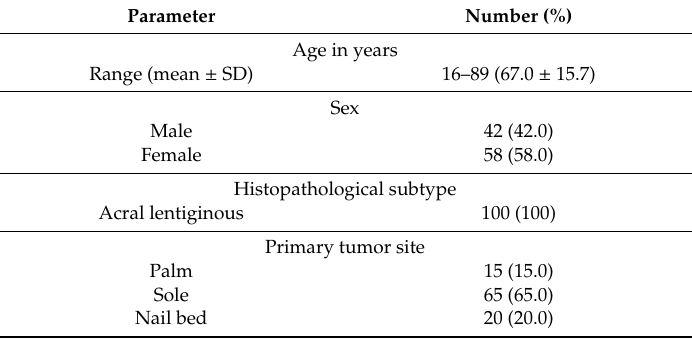
Table 1. Clinicopathological data of patients with invasive acral